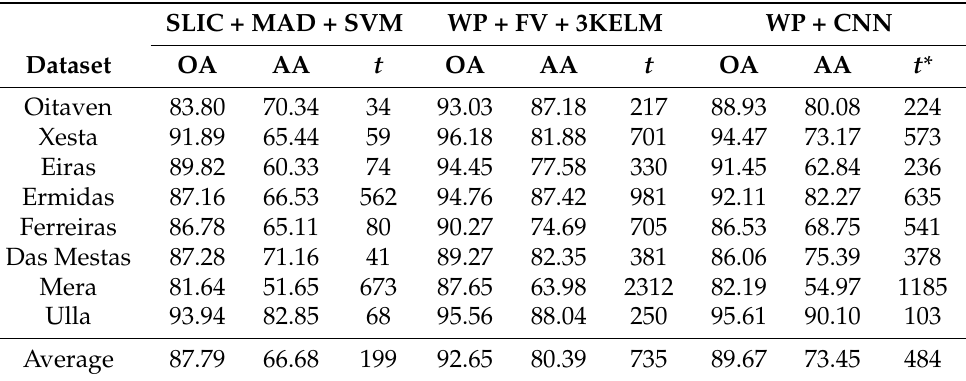
Table 3. Classification accuracies and execution times obtained by three algorithm chains: fast (SLIC + MAD + SVM), high accuracy (WP + FV + 3KELM), and deep-learning (WP + CNN). Results are for 15% of training superpixels and execution times displayed in seconds ( t * indicates that the CNN was run on a GPU).